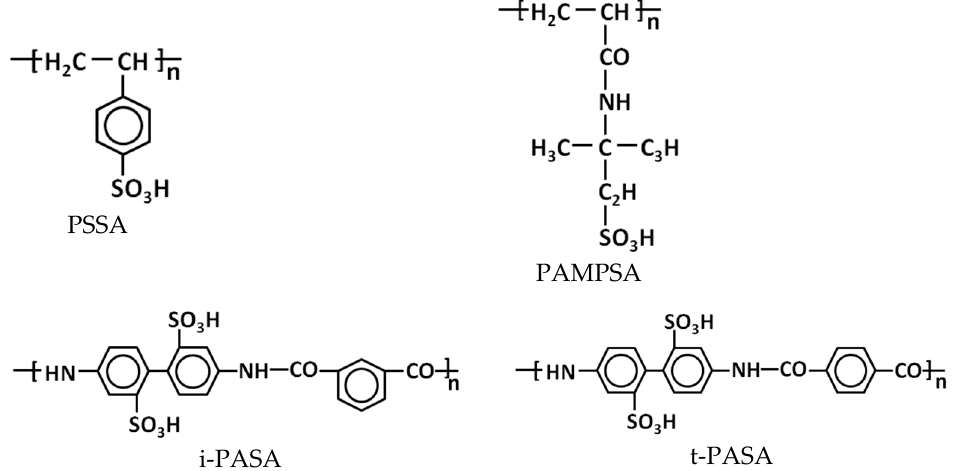
Figure 1. Chemical structure of constitutional units of polysulfonic acids used in the paper. The conditions of electrosynthesis have been described in [23] for PEDOT, in [16,22] for PPy and in [24,25] for PANI. All syntheses were performed in the galvanostatic regime on glass substrates (8 × 40 mm) covered with a transparent conducting layer of SnO 2 :F (FTO) with a sheet resistance of ca. 7 ohm/square. A platinum foil was used as a counter electrode and a saturated silver–silver chloride electrode (Ag/AgCl/KClsat) as a reference electrode. The concentrations of EDOT and pyrrole were 10 mM and that of aniline was 25 mM. The ratio of the concentrations of the monomer and sulfoacid groups was always kept as 0.5 mol to 1 g equivalent of the sulfoacid groups. The current densities were 50 µA/cm 2 for PEDOT, 100 µA/cm 2 for PPy and 20 µA/cm 2 for PANI. The surface area for all films was 2.0 cm 2 . All the samples were thoroughly rinsed with deionized water after elec- trosynthesis and dried in air. The charge spent for the synthesis of CP films was 50 mC/cm 2 . The thickness of CP polyacid films depending on the polyacid used were (nm): 150–250 (PANI), 200–300 (PEDOT) and 120–220 (PPy). The thicknesses of the films were measured with a MII-4 microinterferometer (LOMO, Russia). 2.2. Sensing Experiments and Instrumentation The ammonia-sensing properties of CP films were studied as described in [16]. The films, electrodeposited on transparent FTO substrates, were placed in a closed 5 cm spec- trophotometric quartz cell, filled with ammonia vapors in equilibrium (at 22–25 °C) with a 5 mm layer of the aqueous solutions of different NH 3 concentrations prepared through dilution of the 30% solution (Chimmed (Russia), analytical grade). The concentrations of ammonia in air (ppm) were calculated using an interpolated calibration curve based on the values for NH 3 partial pressure over ammonia aqueous solutions presented in [30]. UV-visible NIR (350–1000 nm) absorption spectra of CP films electrodeposited on FTO in air and exposed to the ammonia were registered using the AvaSpec 2048 spectrophotom- eter. The spectrum recording time was 2 s. In general, the usability of a particular material as a sensor is determined by its sen- sitivity (detection limit) and response time, the concentration dependence of the response amplitude and the reversibility of changes in the measured parameter. In our case, this was the absorbance at the chosen wavelength(s) specific for each CP. Another criterion to choose these wavelengths is that they should be close to the standard wavelength of one of the light-emitting diodes, which can be used in optical pair detectors in practice instead of a spectrophotometer. The sensor response amplitude ( ∆ A) was calculated as: ∆A = A (cid:2898)(cid:2892) (cid:3119) (cid:2932)(cid:2911)(cid:2926) − A (cid:2911)(cid:2919)(cid:2928) A (cid:2911)(cid:2919)(cid:2928) 100%